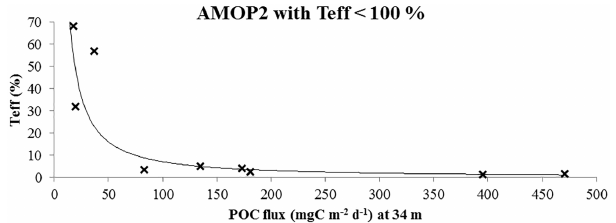
Figure 5. Vertical transfer efficiency for POC ( T eff ) versus POC flux at the upper trap. T eff versus POC flux in mgCm − 2 d − 1 at 34m for the AMOP winter–spring (denoted AMOP2) dataset filtering samples with T eff > 100% (thus excluding AMOP2-S1, AMOP2- S3 and AMOP2-S6; see Sect. 3.1.2), with a power tendency line ( R 2 = 0 .